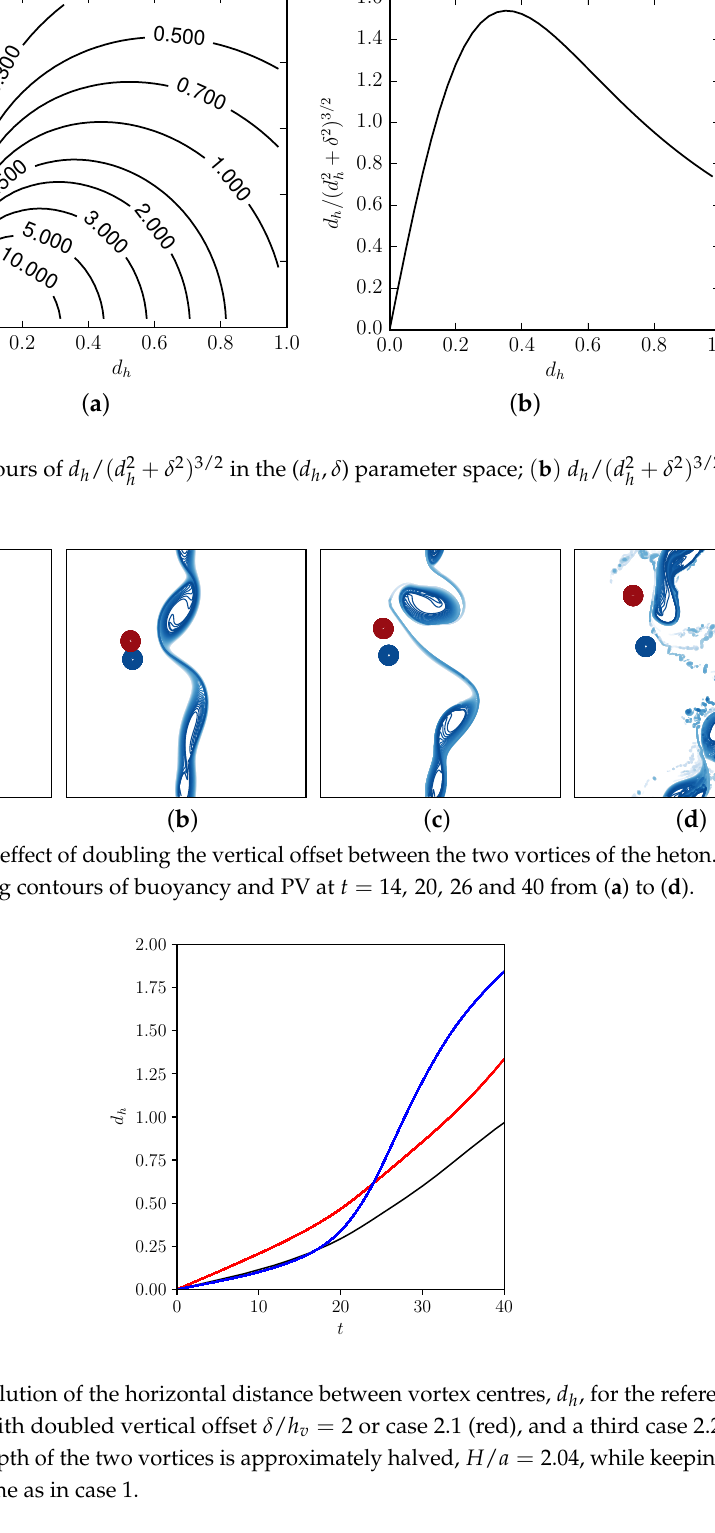
Figure 9. Time evolution of the horizontal distance between vortex centres, d h , for the reference case 1 (black), the case with doubled vertical offset δ / h v = 2 or case 2.1 (red), and a third case 2.2 (blue) in which the mean depth of the two vortices is approximately halved, H / a = 2.04, while keeping all other parameters the same as in case